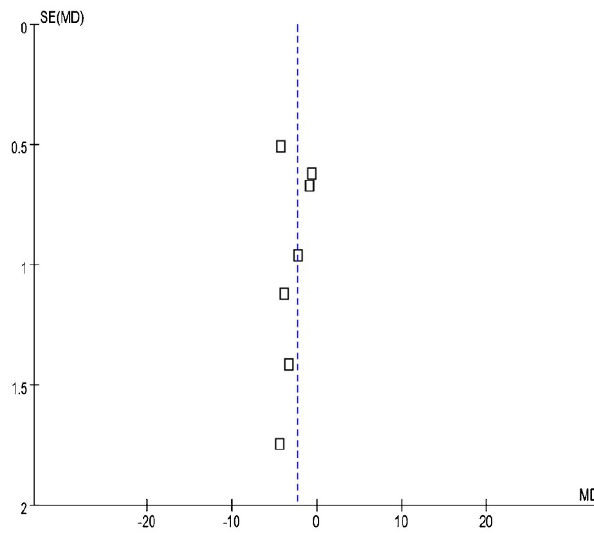
Figure 3 - Funnel plot for the comparison of standardized mean differences of fracture healing time demonstrating the evidence of publication